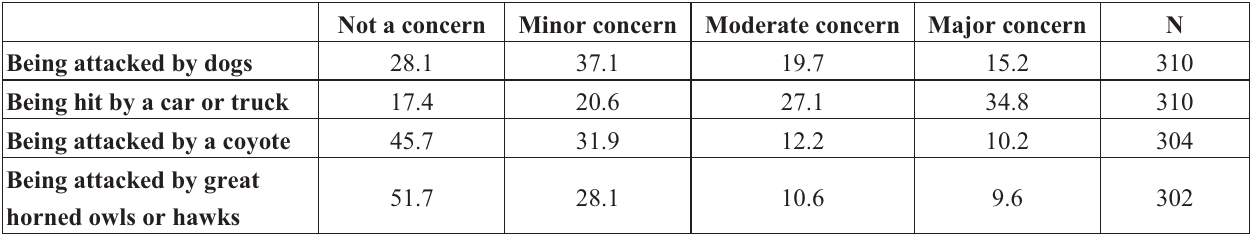
Table 8. Pet owners’ responses to: “Please indicate how concerned you are that the following could happen to cats that are unsupervised and off-leash in the D.C. metro area.” Given in